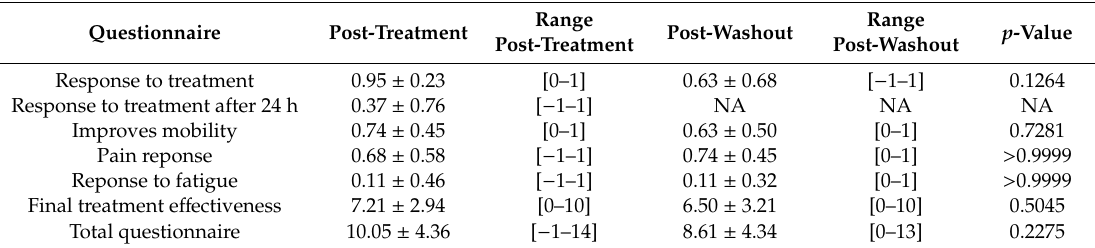
Table 7. FM&ME / CFS patient subgroup response to therapy, assessed by score-di ff erences in our